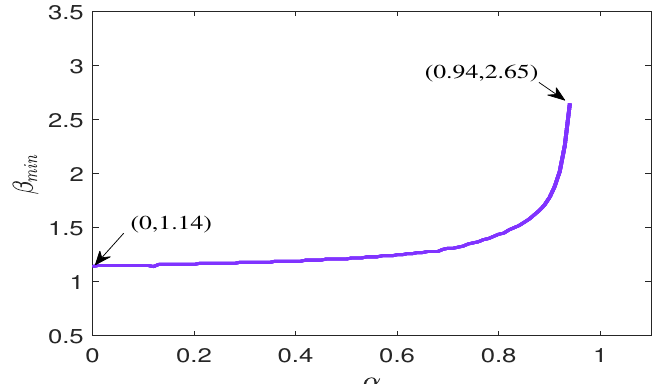
Figure 5. Curve of ϕ vs. ψ min for the OBC